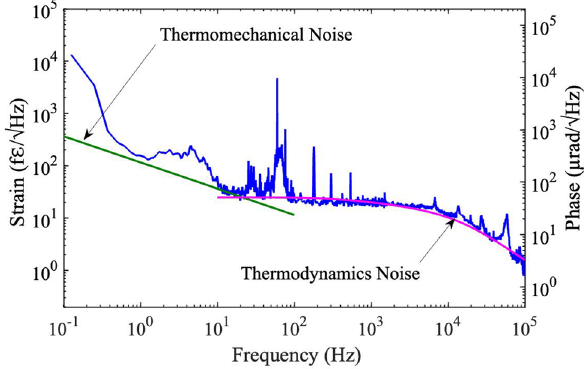
Figure 4. Noise-limited resolution of the MZ-FP interferometer (in strain and phase). Also shown are theoretical predictions of the noise floor due to fiber thermal noise, which indicates thermal-noise-limited operation at frequencies above 10